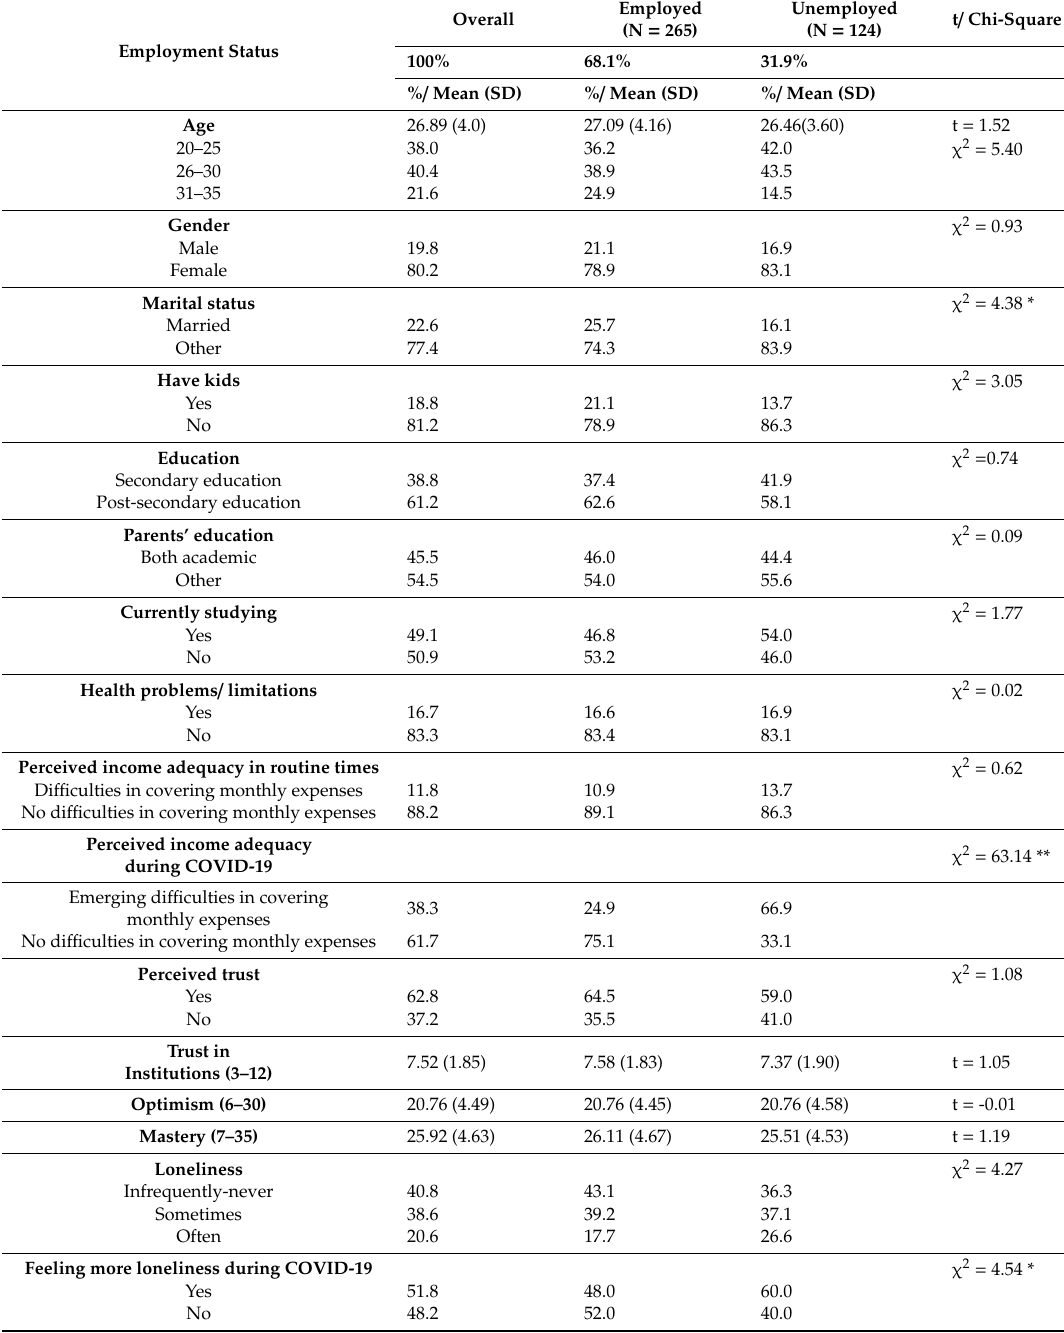
Table 1. Descriptive statistics of the study variables by employment status (N =